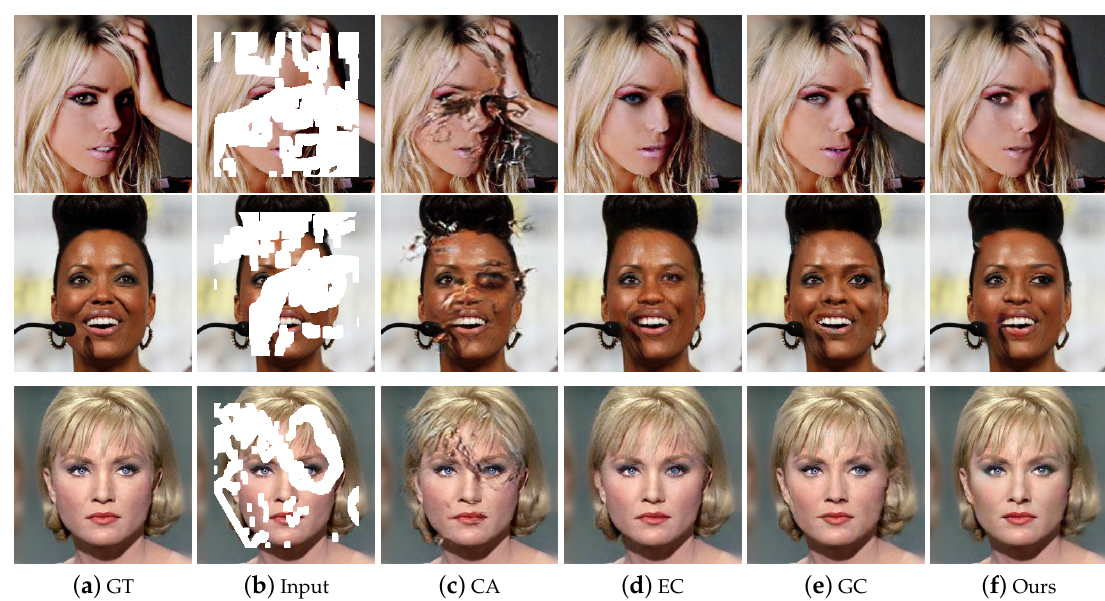
Figure 5. Qualitative comparisons of different methods on CelebA-HQ [24] with irregular masks.